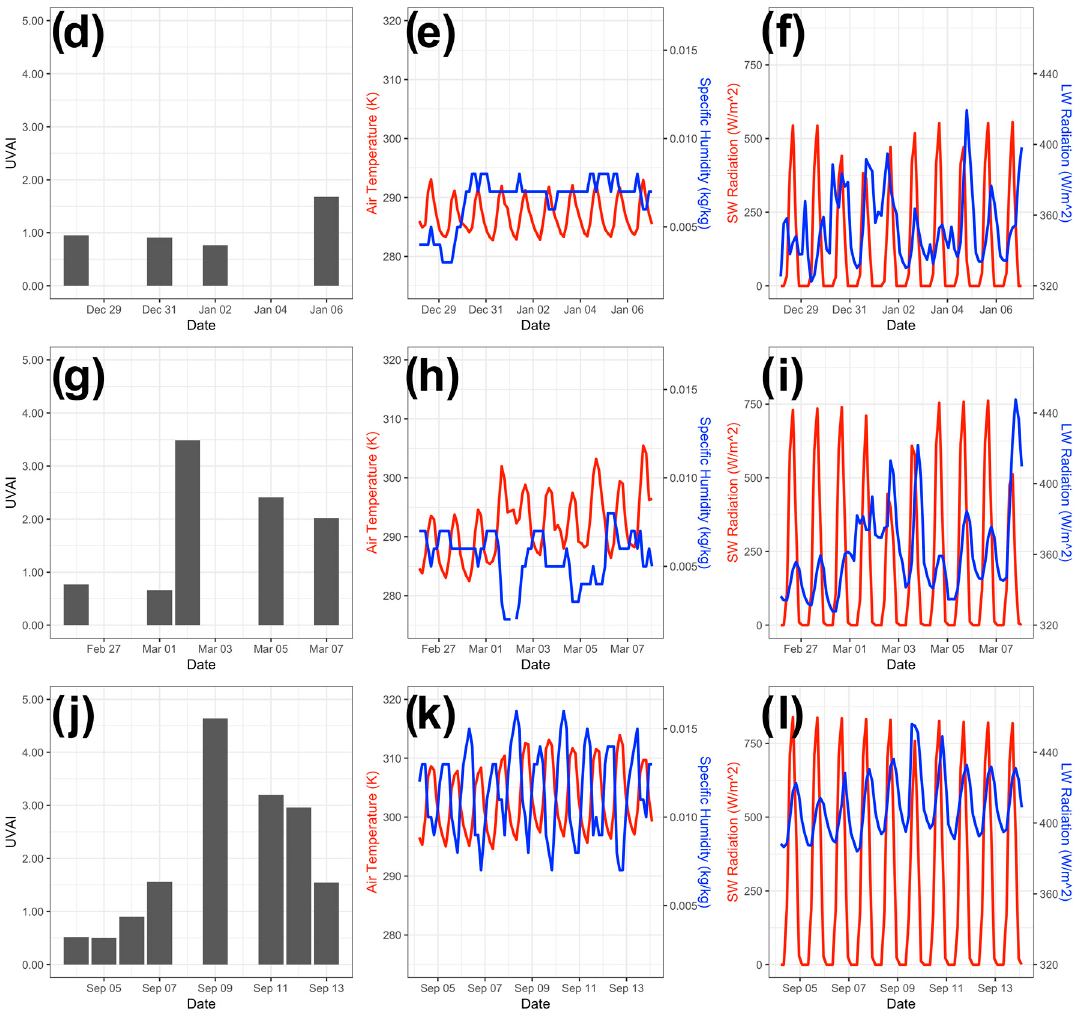
Figure 8. The Ultra Violet Aerosol Index (UVAI) ( a , d , g , j ), air temperature, and specific humidity ( b , e , h , k ), shortwave (SW) and longwave (LW) radiation ( c , f , i , l ) values recorded before and after